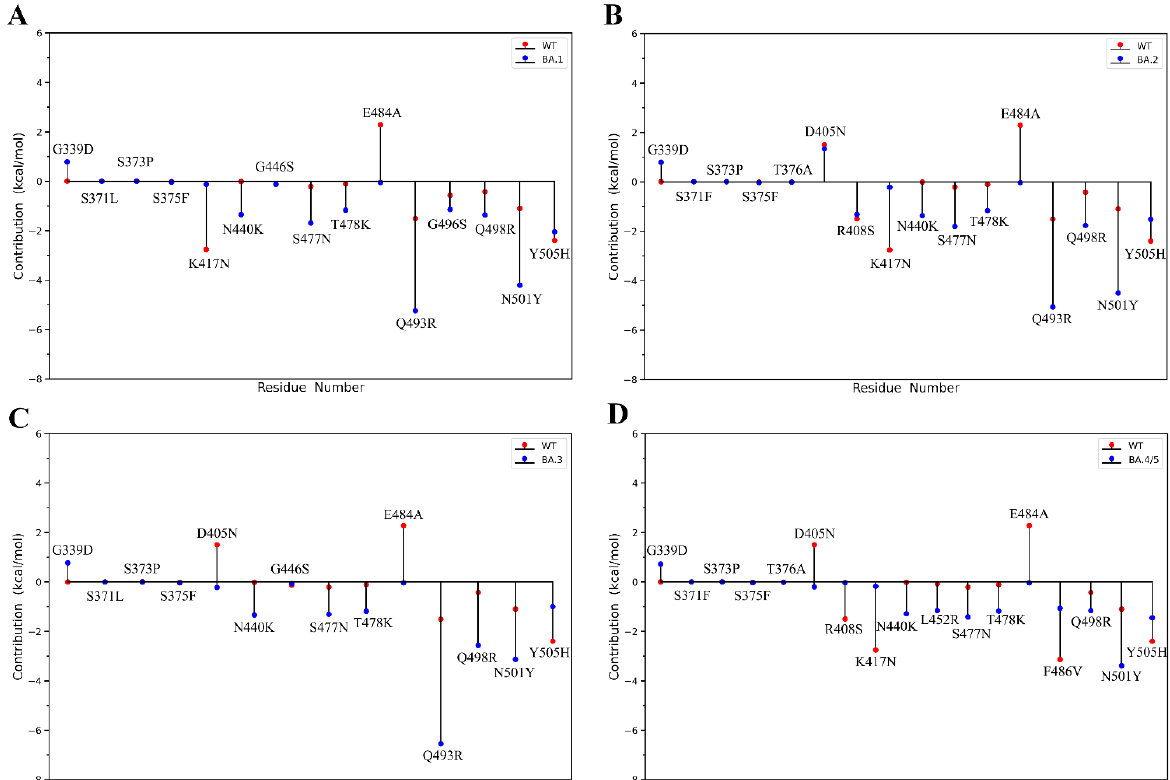
Figure 5. Per-residue contributions of each mutation site to binding free energy (BFE) values calcu- lated using MM-PBSA method. ( A ) RBD BA.1 and RBD WT . ( B ) RBD BA.2 and RBD WT . ( C ) RBD BA.3 and RBD WT . ( D ) RBD BA.4/5 and RBD WT . Note: If the residue site with per-residue BFE value is lower in RBD OMI s than in RBD WT , it indicates that mutation at this site makes a positive contribution to enhancing the ACE2-binding affinity of RBD OMI